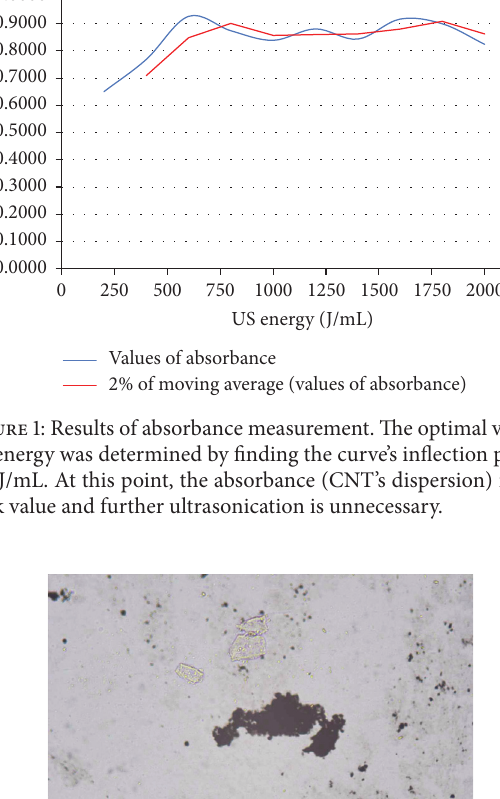
Table 4: CEN standardized sand’s particle size distribution [24].